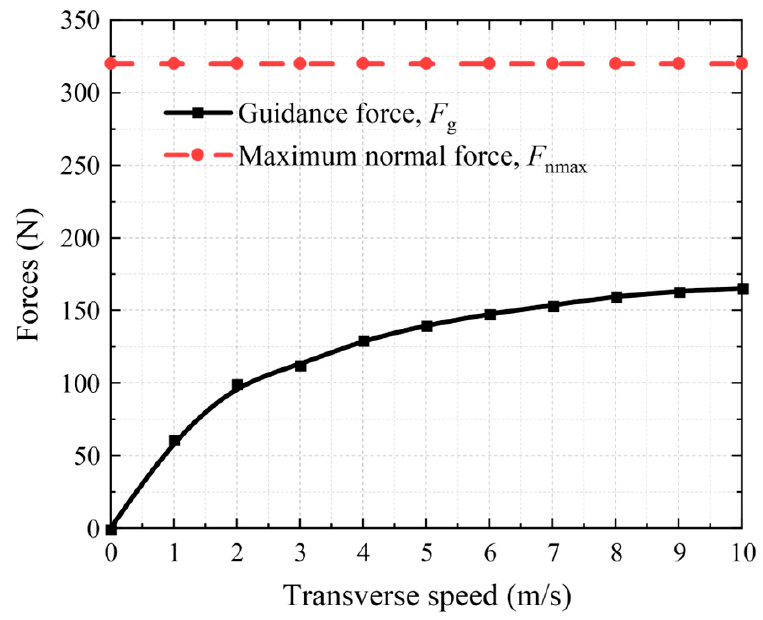
Figure 8. The guidance force and maximum normal force as functions of transverse speed at a working gap of 27 mm (the working gap refers to the distance between the bottom of the PM and the top surface of the guidance track).